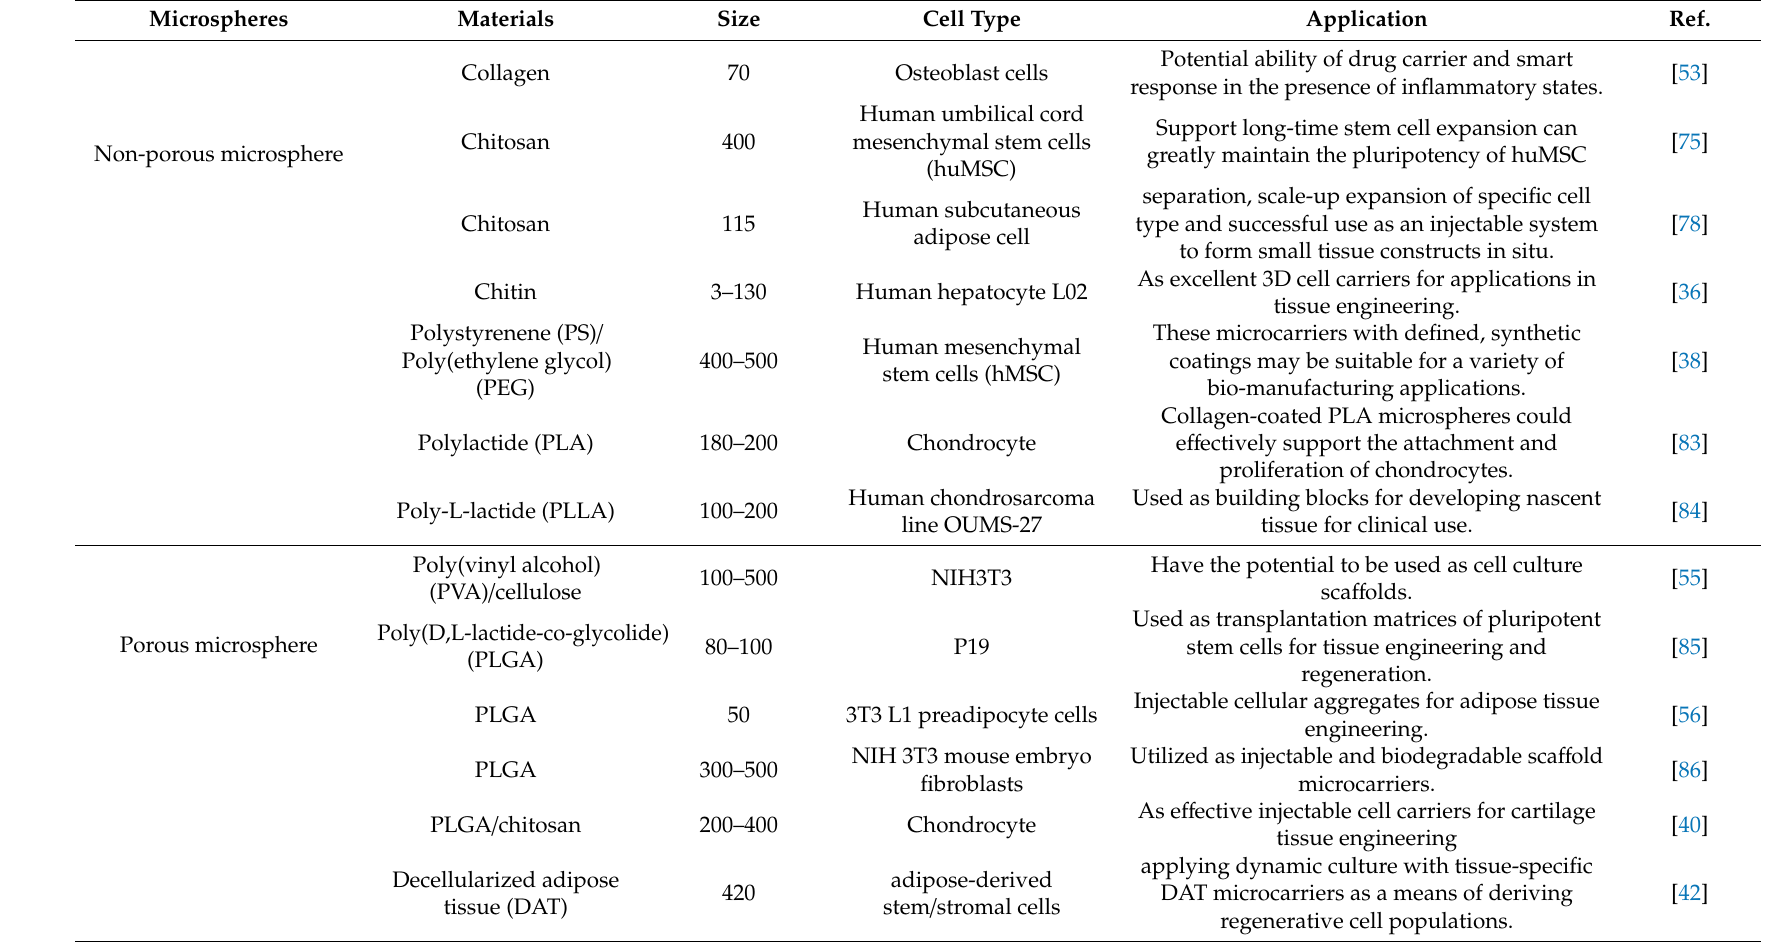
Table 2. Microspheres and their applications in cell